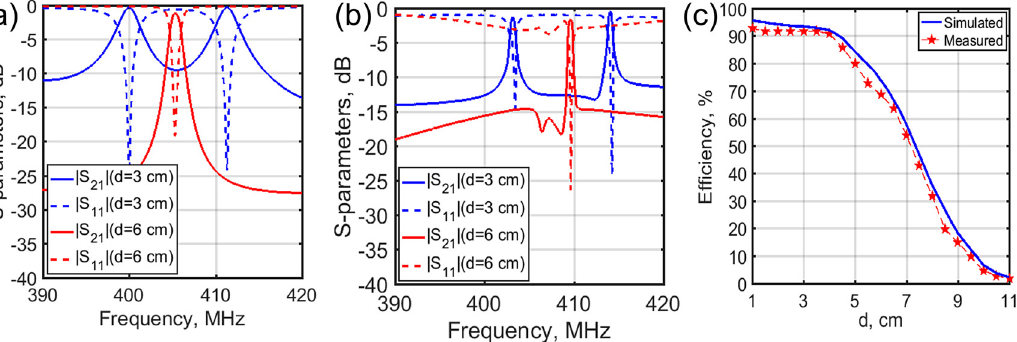
Figure 7: Measured and simulated characteristics of the NR WPT system as a function of separation d . (a) Simulated and (b) measured S-parameters of the WPT system operating at the NR mode. (c) The measured and simulated power transfer efficiency.